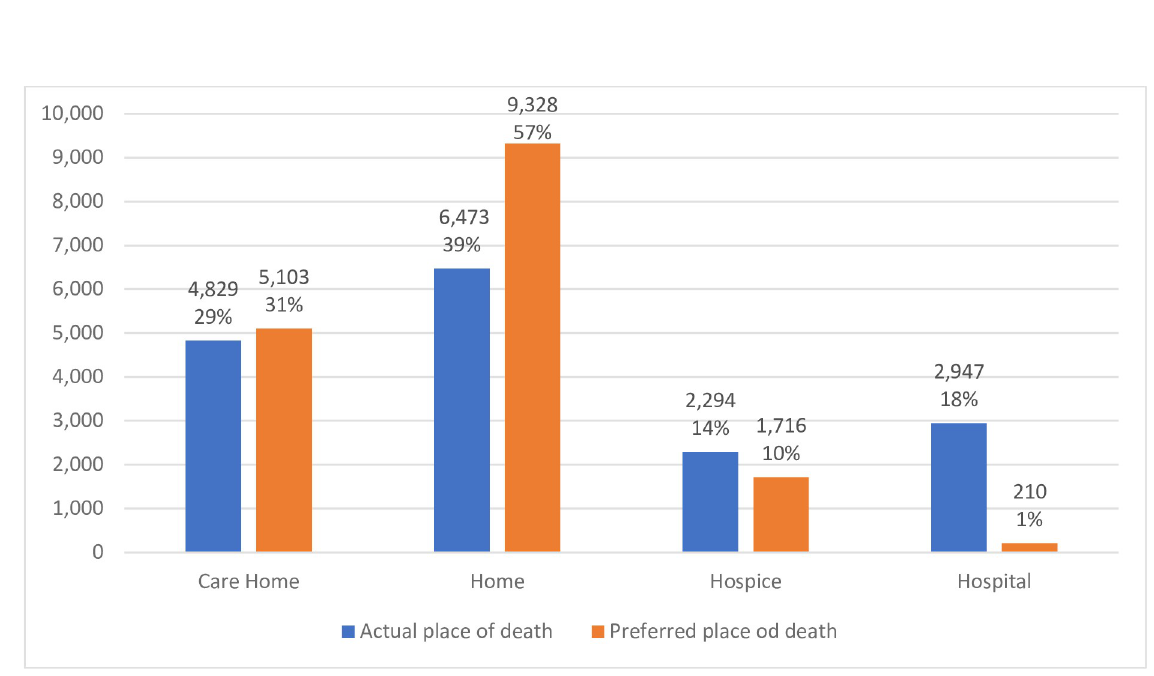
Fig 1. Comparison between actual and preferred place of